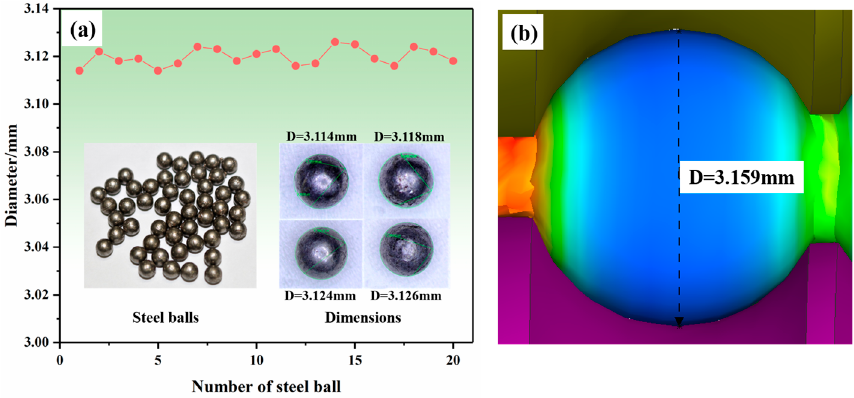
Figure 3. Comparison of the diameter values of steel balls: ( a ) experimental results and ( b ) simulation results.